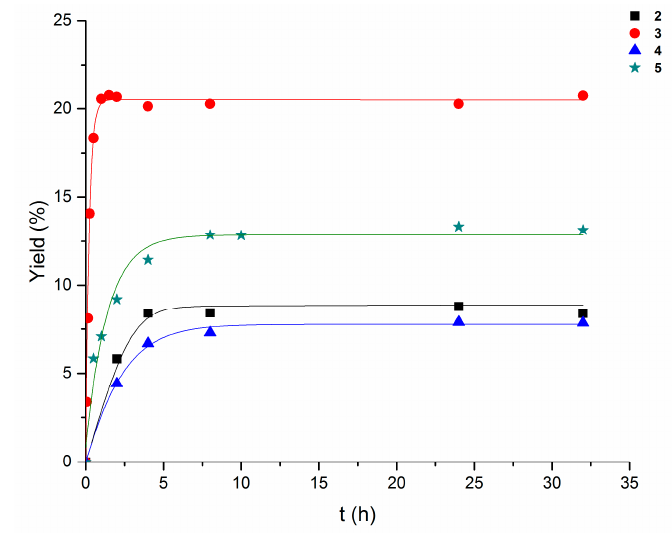
Figure 3. Accumulation of oxygenates with time in the cyclooctane (initial concentration 0.25 M) oxidation with H 2 O 2 (1.2 M) catalyzed by 2 – 5 in acetonitrile at 60 °C.